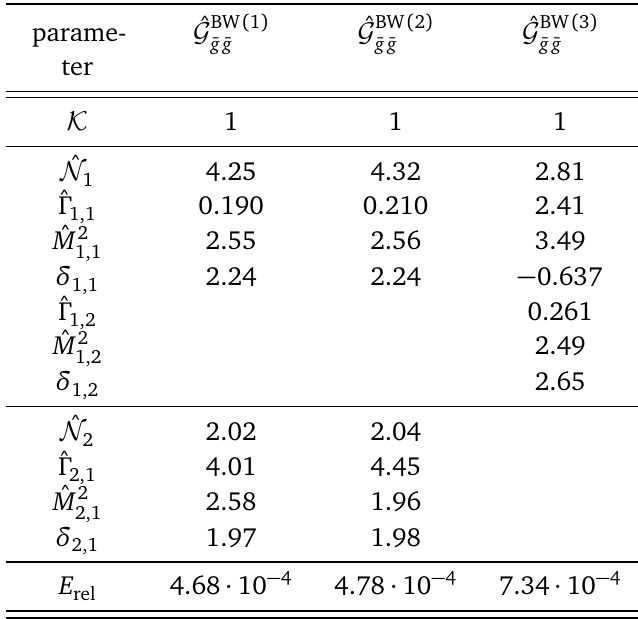
Table 2: Parameters for the reconstruction of the background graviton spectral function (central line in